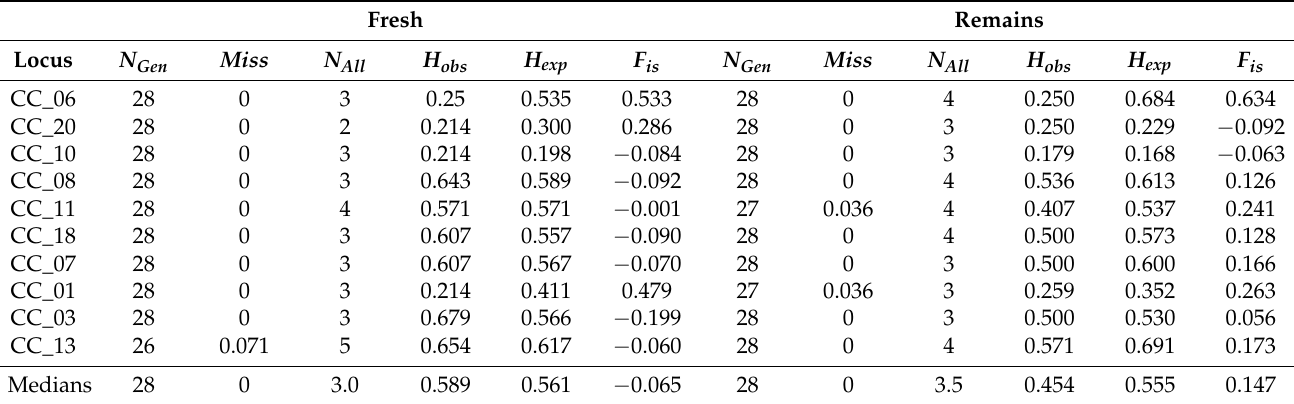
Table 1. Population genetic parameters estimated for the two types of samples groups (fresh—samples taken from alive beetles; remains—samples of body remains): N Gen —number of genotypes, Miss —proportion of missing data, N All —number of alleles, H exp —expected heterozygosity, H obs —observed heterozygosity, F is —inbreeding